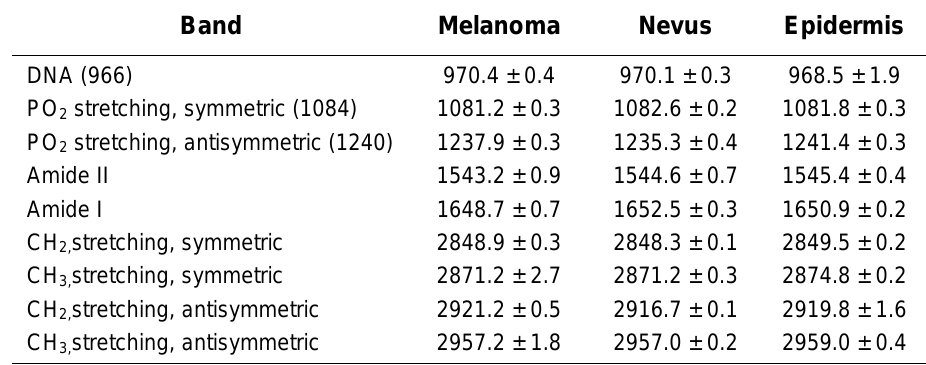
Variations in Absorbance Maxima between Epidermis, Nevus, and Melanoma Tissue in the Mid-IR Region as Deduced from Second Derivative